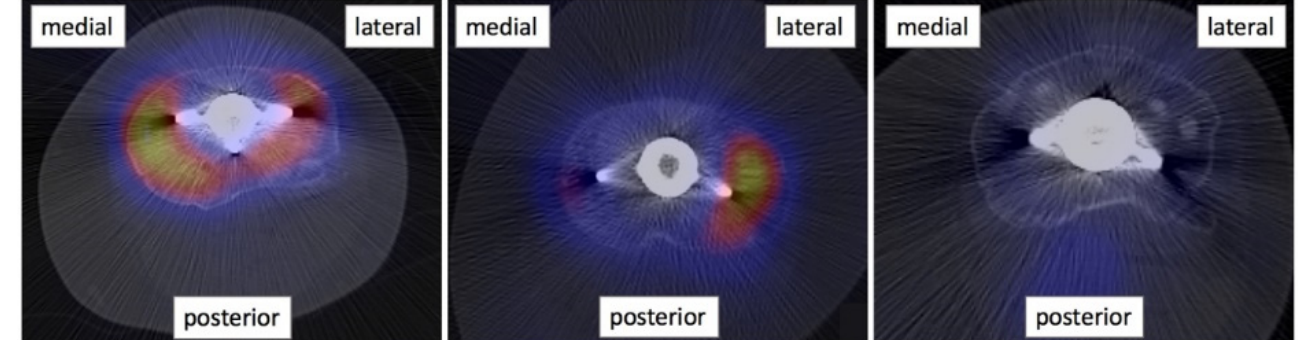
Figure 3. Examples of SPECT/CT images with axial view on the tibial tray. From left: knee with most extended BTU on the medial side of the tibial tray (asymmetrical distribution); knee with most extended BTU on the lateral side of the tibial tray (asymmetrical distribution); no increased BTU detected (symmetrical distribution).